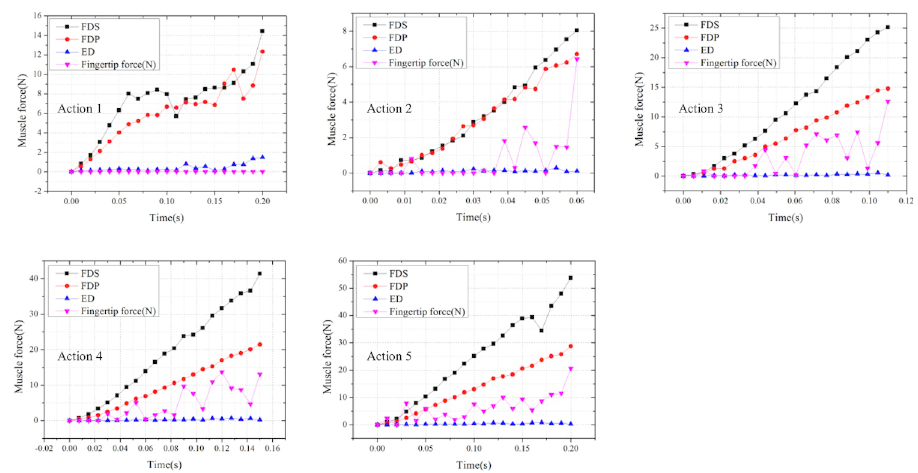
Fig 10. Variation of muscle forces and fingertip forces over time in three muscles during flexion